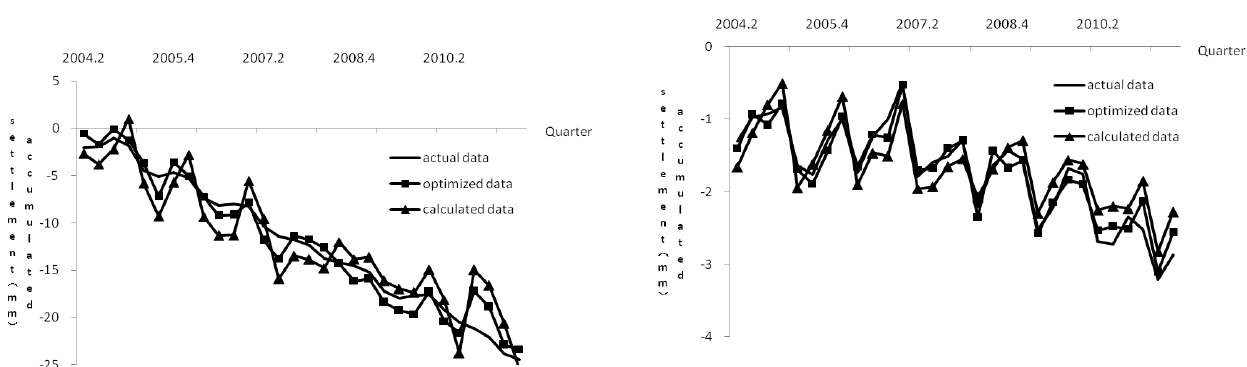
Figure 6. The calculated, actual and optimized value of